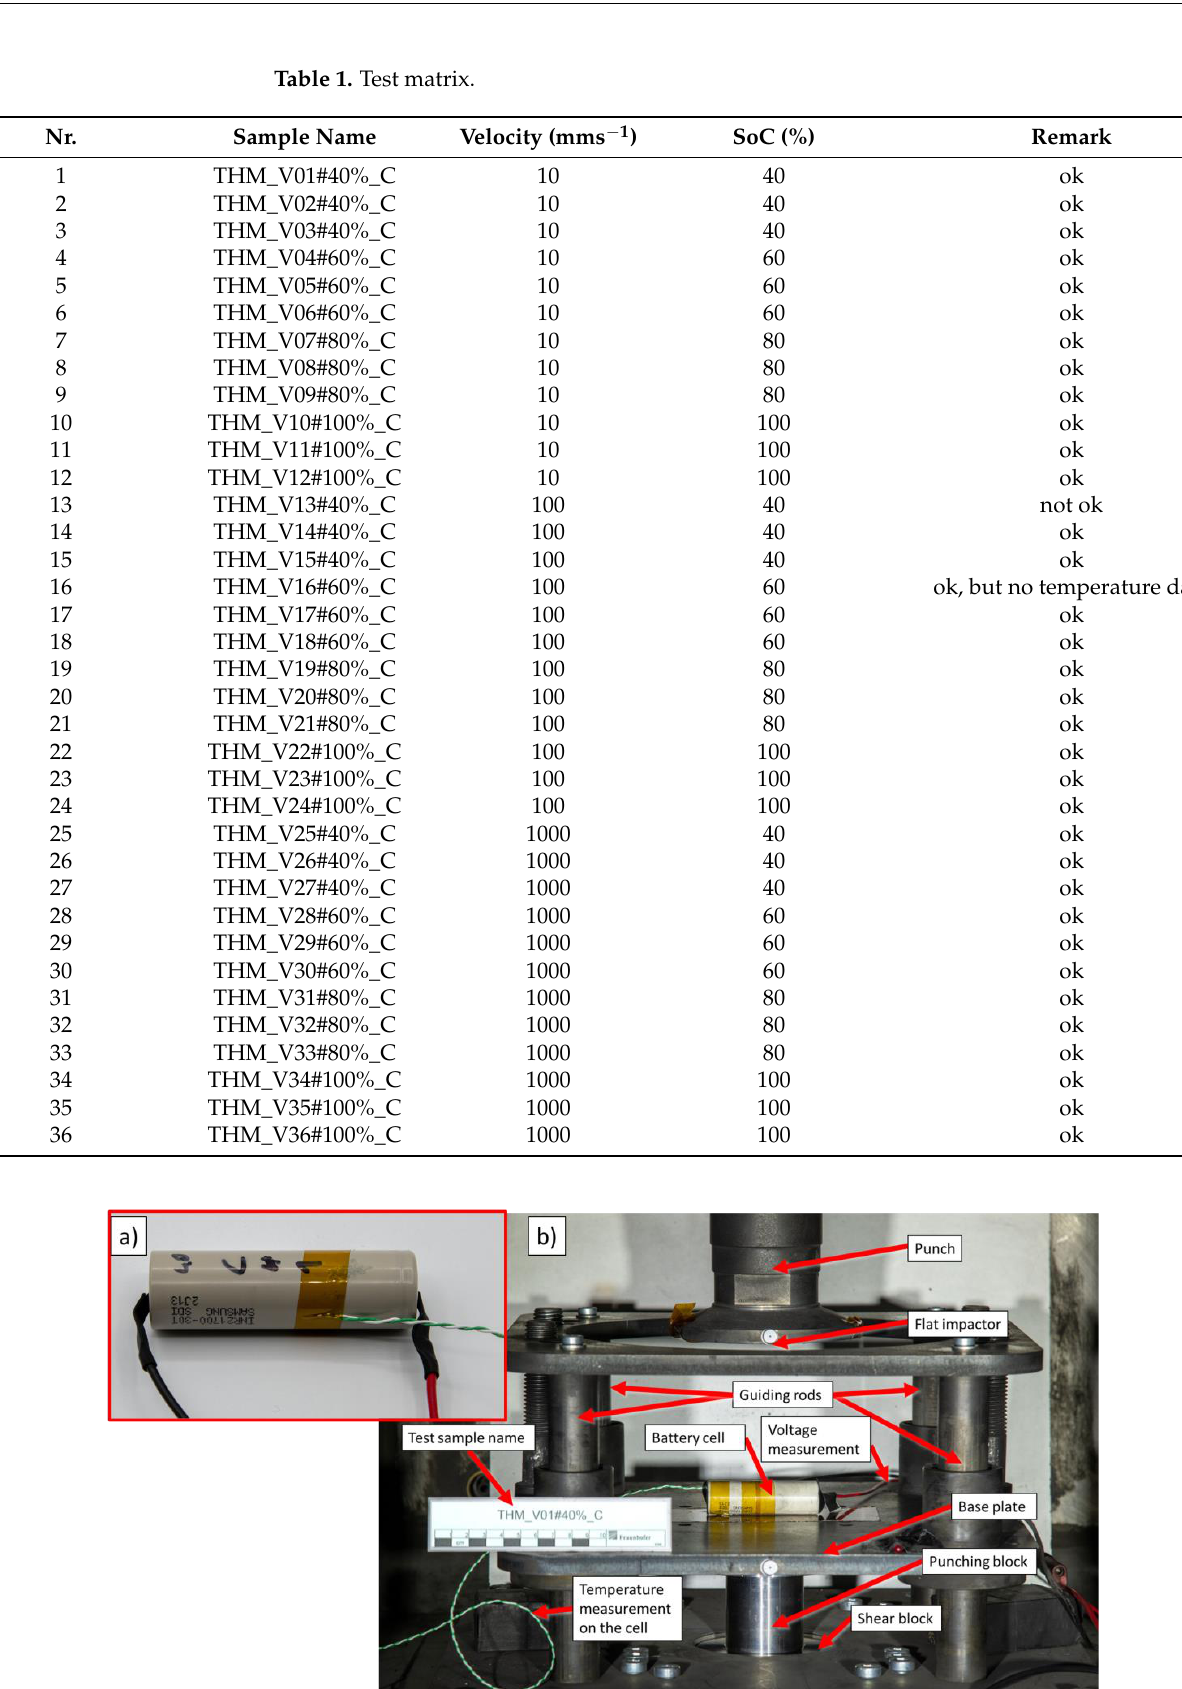
Figure 5. Experimental setup of 21,700 battery cell ( a ), in the test chamber ( b ).